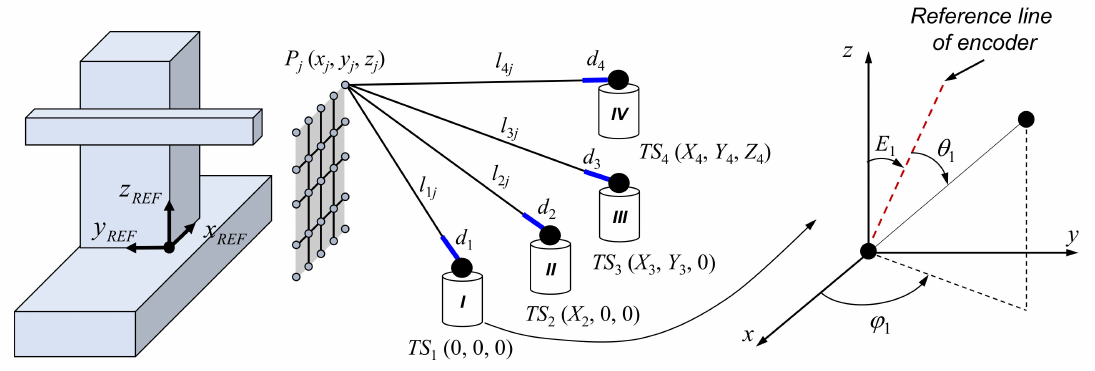
Figure 3. Schematic of estimating elevation angle o ff sets and initial guesses of dead